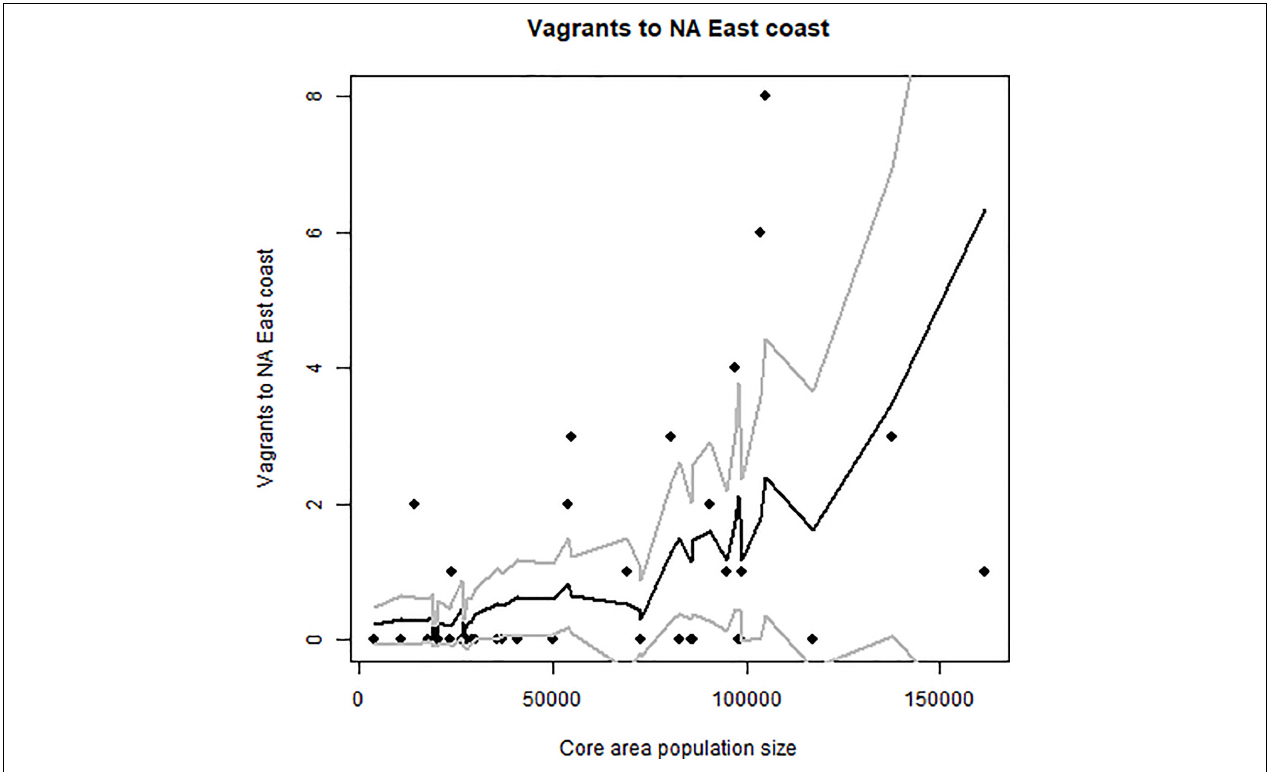
FIGURE 7 | Occurrence of vagrant elegant terns on United States east coast vs. Pacific nesting population size (number of pairs) in the same year. Peak numbers on east coast in 2017–2019. There was a strong El Niño in 2015–16 and a weak one in 2019, but 2017 and 2018 were La Niña (cold water) years. Predicted values and confidence intervals